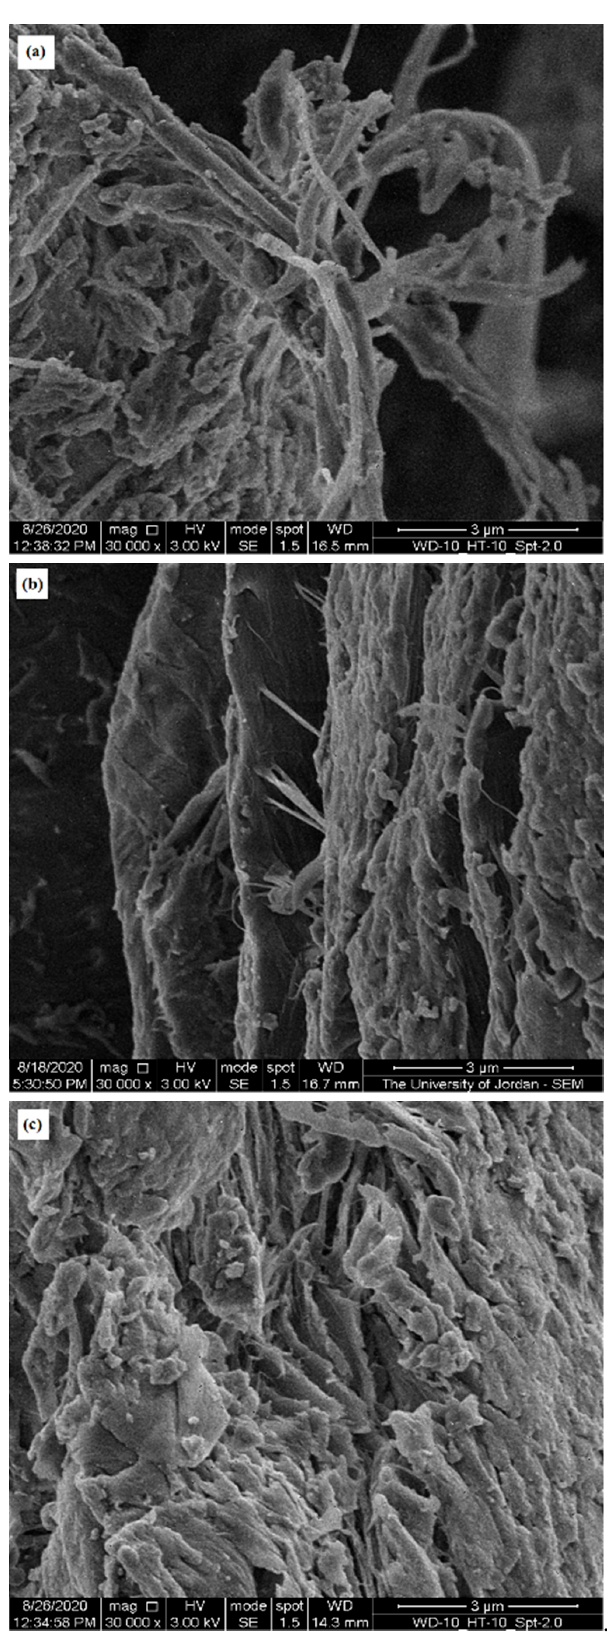
Figure 5. SEM image of ( a ) crab (CH-Cr), ( b ) shrimp (CH-Sh), and ( c ) squid (CH-Sq) CHs at 30,000 × magnification .